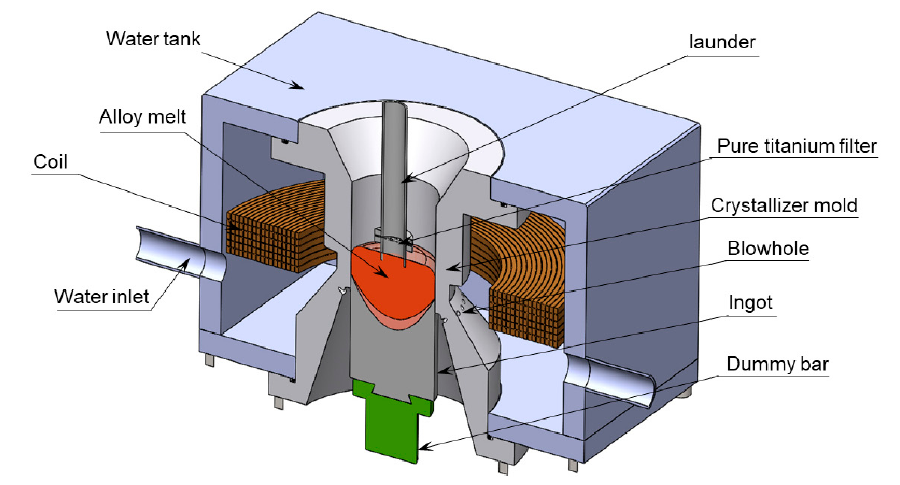
Figure 1. Schematic diagram of low-frequency electromagnetic casting experiment equipment.